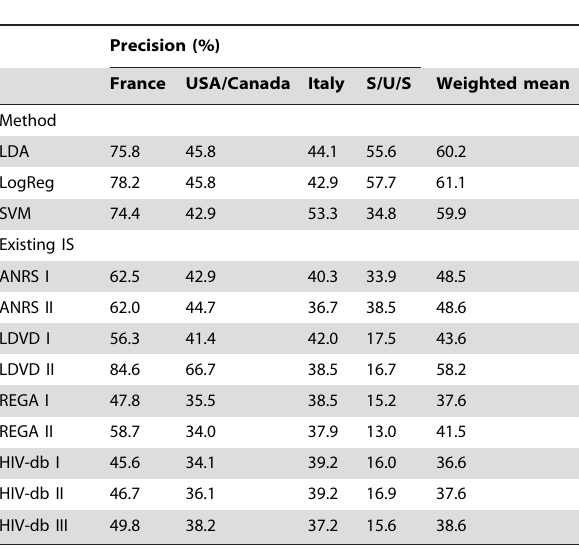
Table 5. Precisions of country-based scores for each country- based data sets including the sample that served for training (S/U/S: Spain/UK/Switzerland; LDA: Linear Discriminant Analysis; LogReg: Logistic Regression, SVM: Support Vector